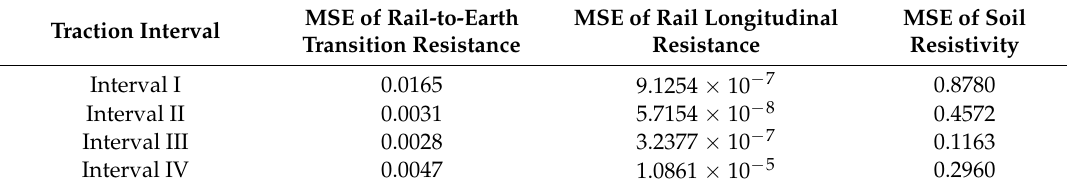
Table 3. Uncertainty evaluation. I